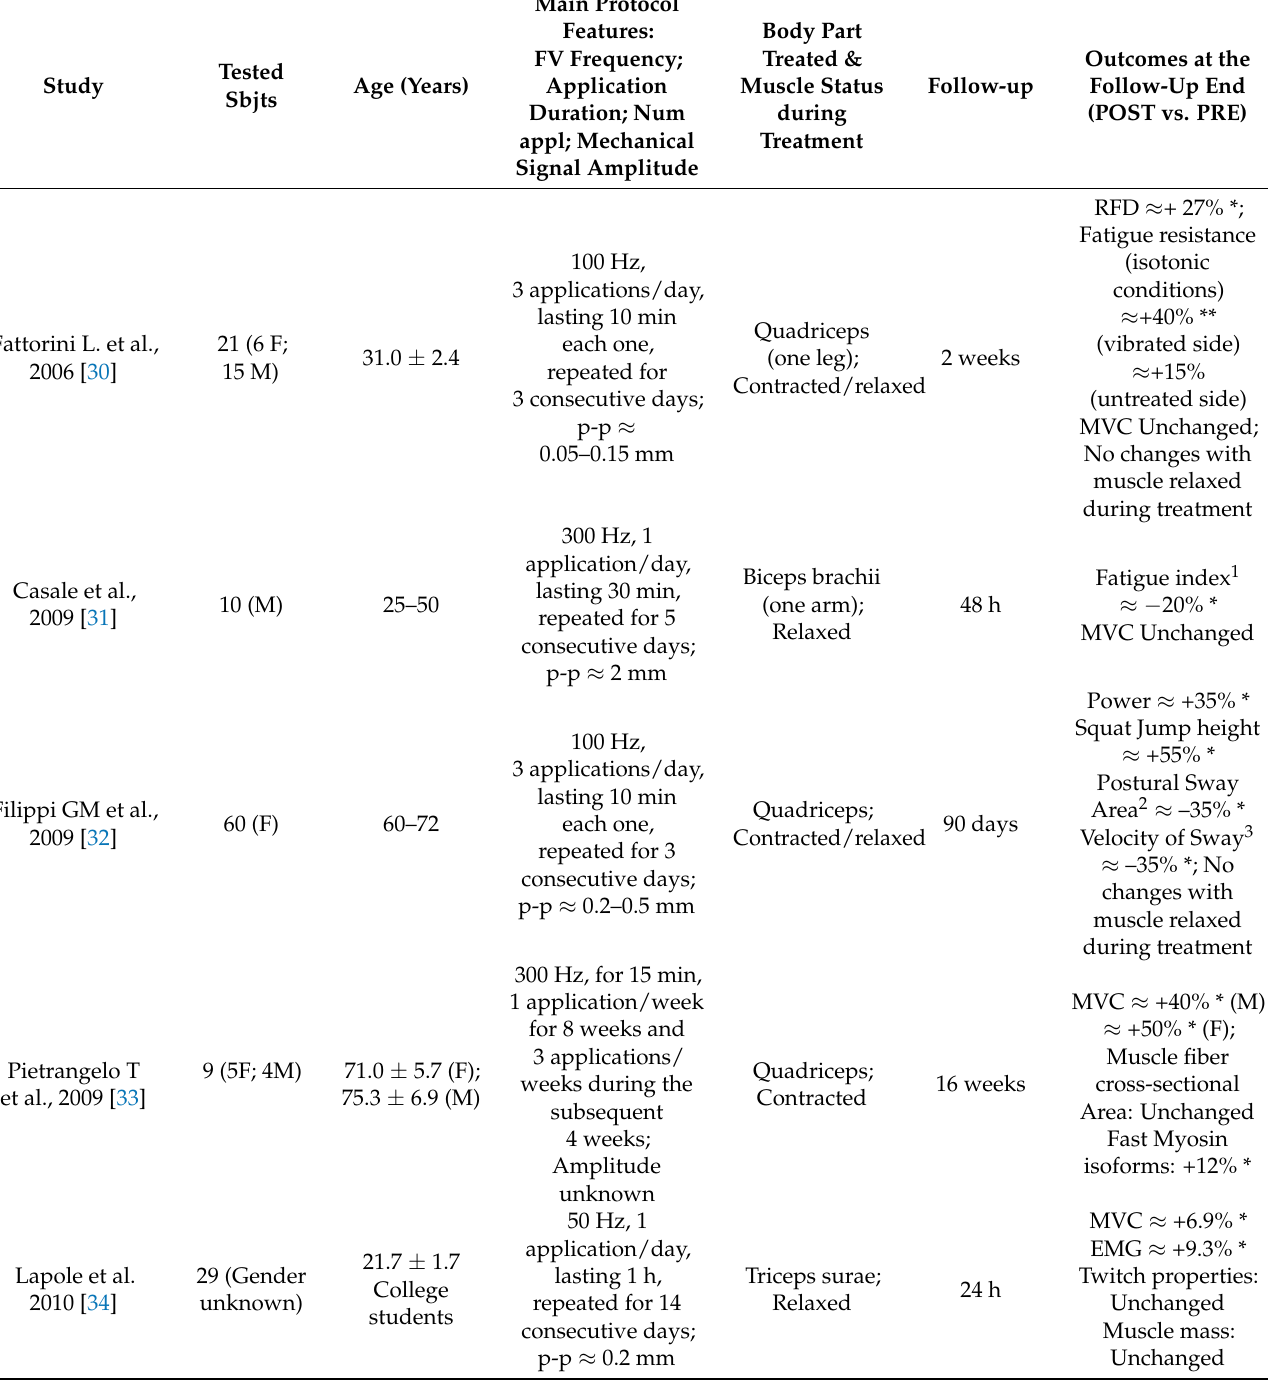
Table 1. Main characteristics of the studies included in the review. The outcome values at the end of the follow-up